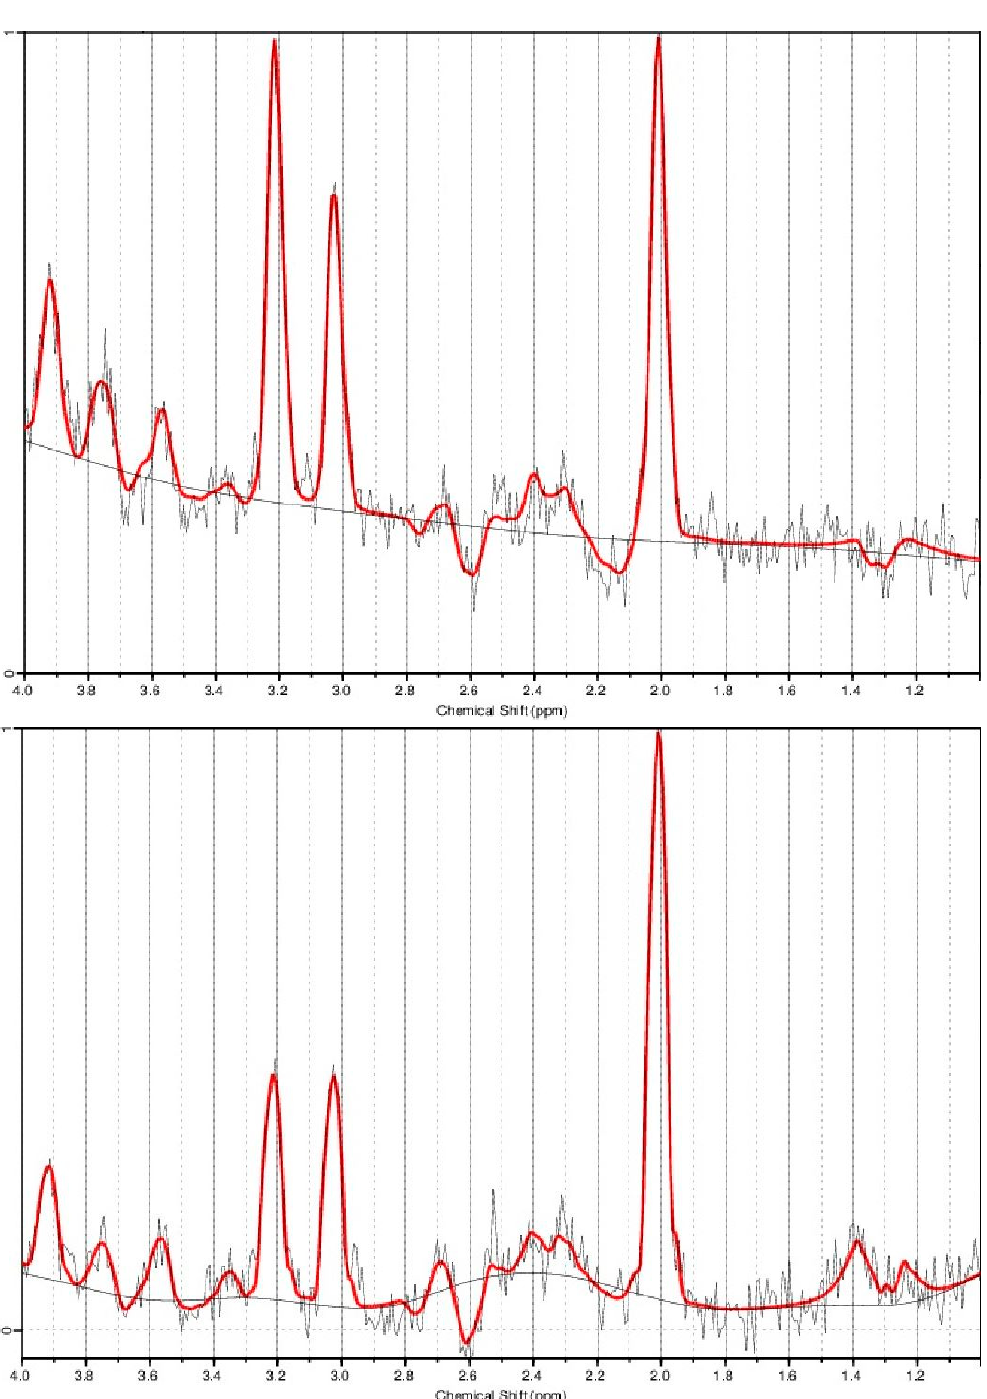
Figure 2. Sample spectra of high fatigue (HF) (above) and low fatigue (LF) (below). The tallest peak represents N-acetylaspartate (NAA) + N-acetylaspartylglutamate (NAAG). The second tallest peak close to NAA + NAAG peak represents creatinine (Cr) + phosphocreatine (PCr). The dispersion of NAA, choline, and creatine peaks is presented in the sample spectra of a single voxel (Figure